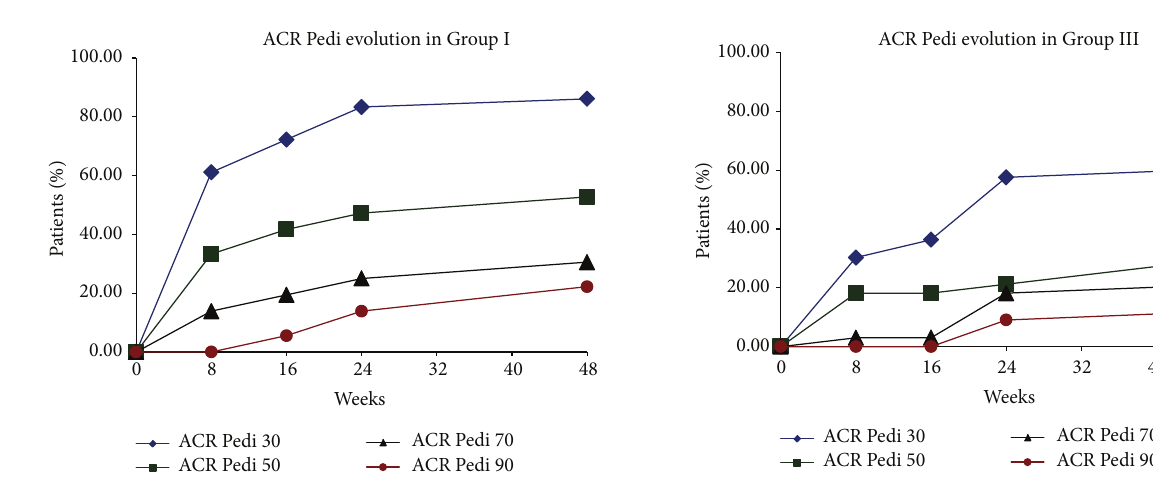
Figure 4: Evolution of ACR Pedi 30/50/70/90 responses in SLBI group.